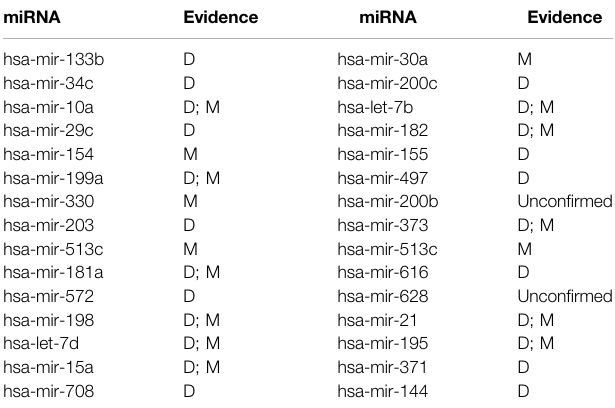
TABLE 2 | The top 30 potential miRNAs associated with prostate